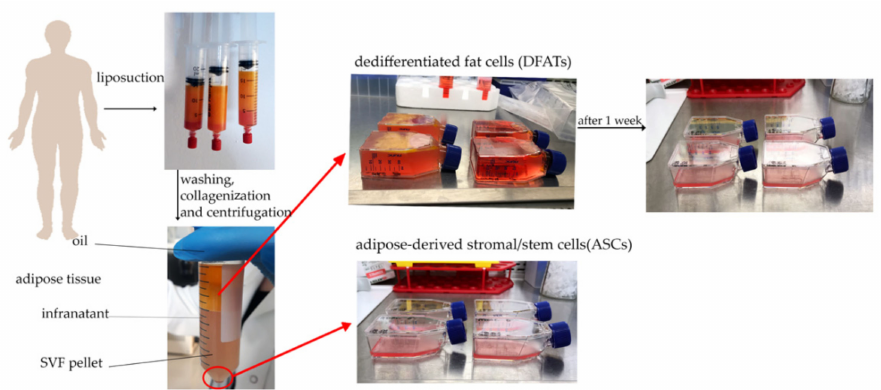
Figure 3. Steps of ASCs and DFATs cell isolation procedure. ASCs cultured as a standard monolayer and DFAT cells cultured using ceiling method. After one week, DFAT cells were reverted and treated with the same culture conditions (5% O 2 , 5% CO 2 , 37 ◦ C) as